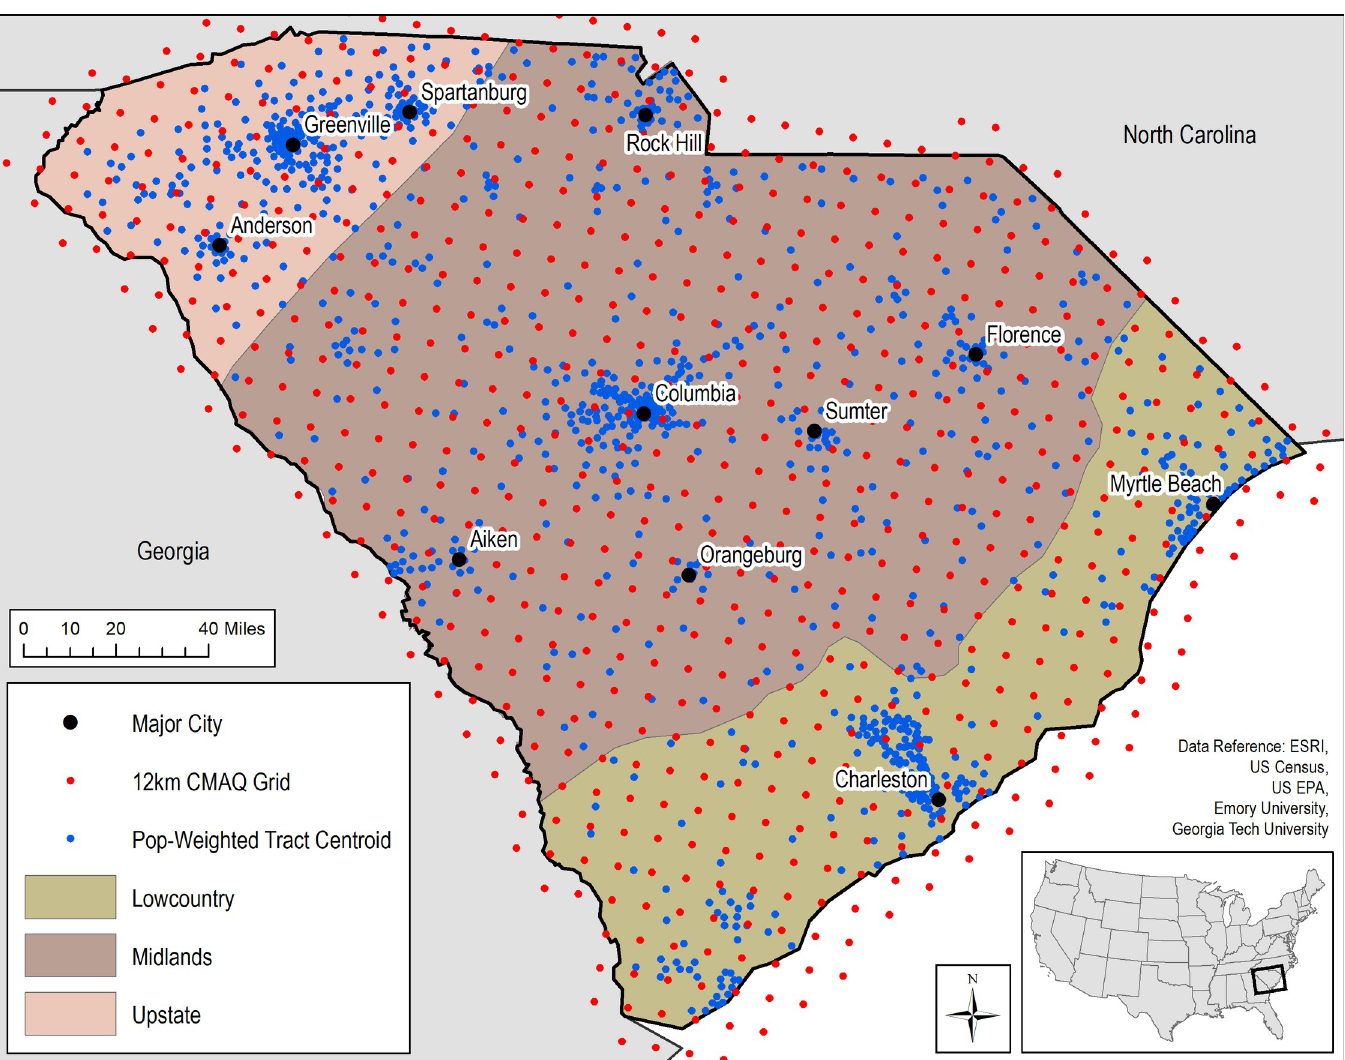
Fig 1. Study area of South Carolina showing its regions, main urban areas, 12 km CMAQ grid point locations, and population weighted census tract centroids (2010 US Census population estimates and